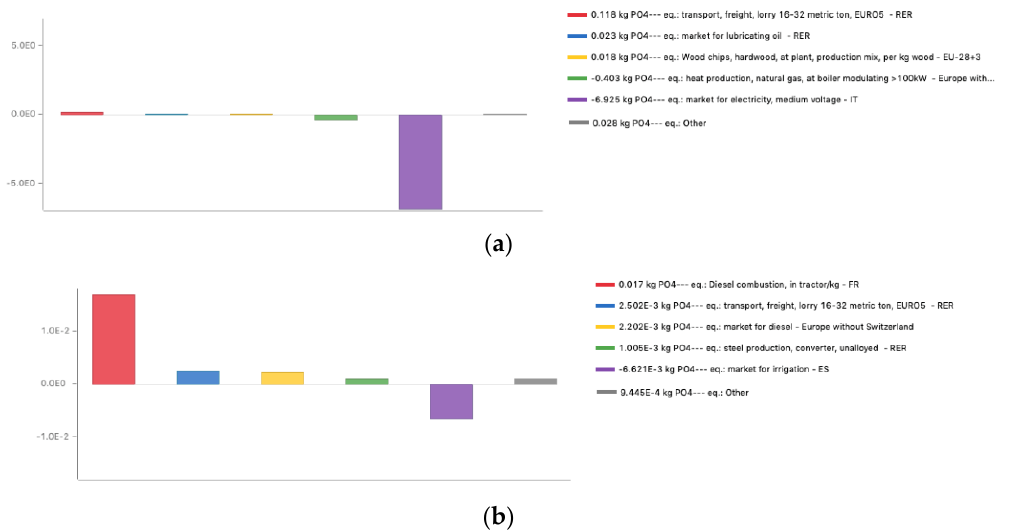
Figure 7. Eutrophication: top 5 contributions impacting category results: ( a ) Cradle-to-grave analysis; ( b ) Downst- ream process.